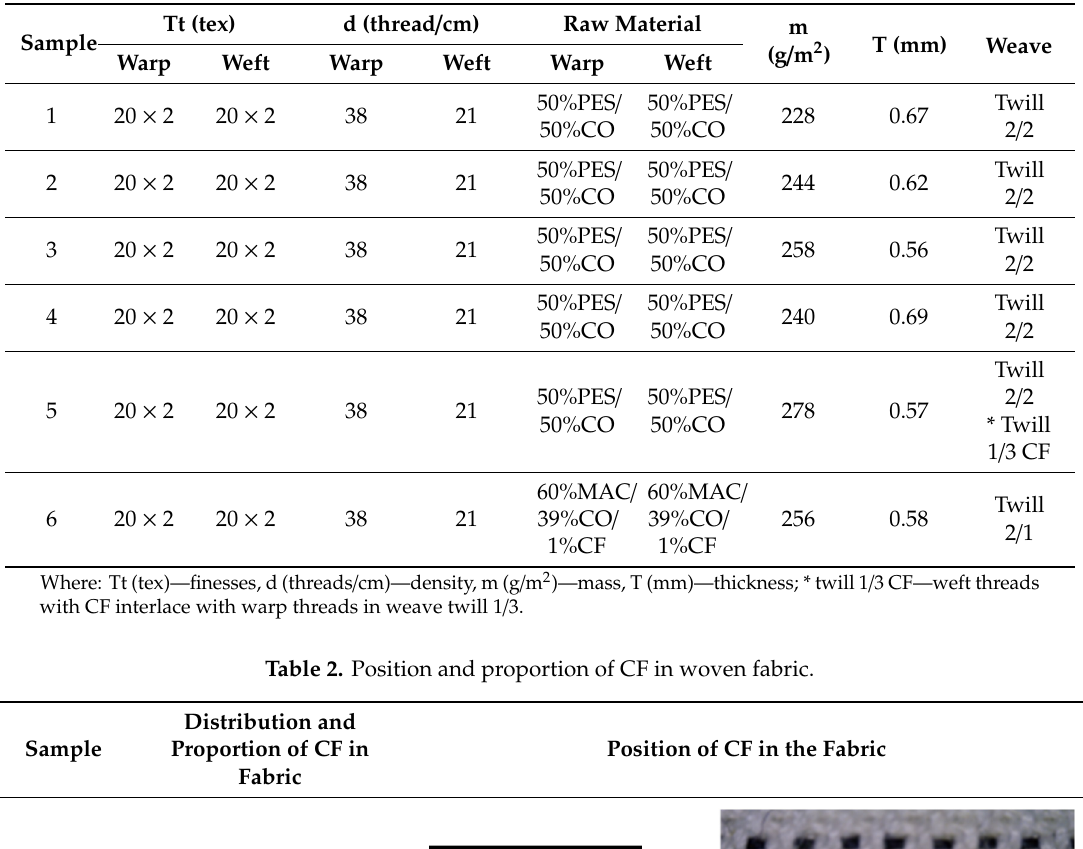
Table 1. Basic structural parameters of woven fabric samples.